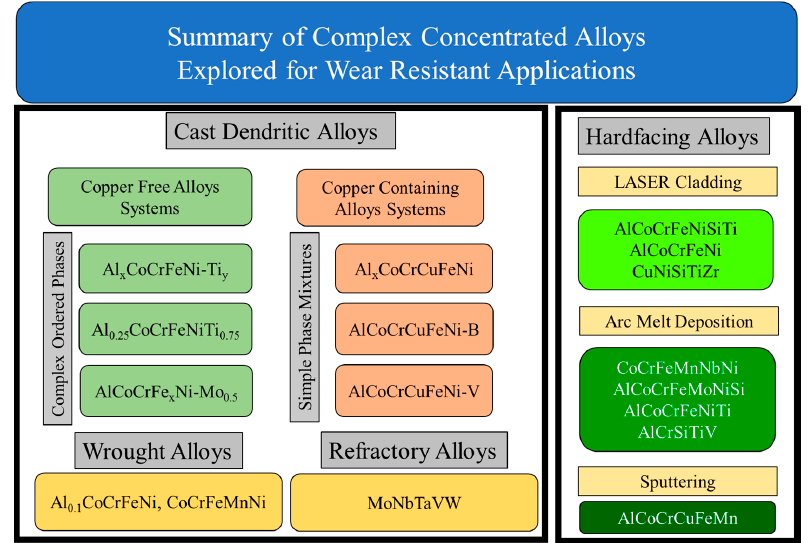
Figure 24. Summary of complex concentrated alloys studied for their tribological behavior.